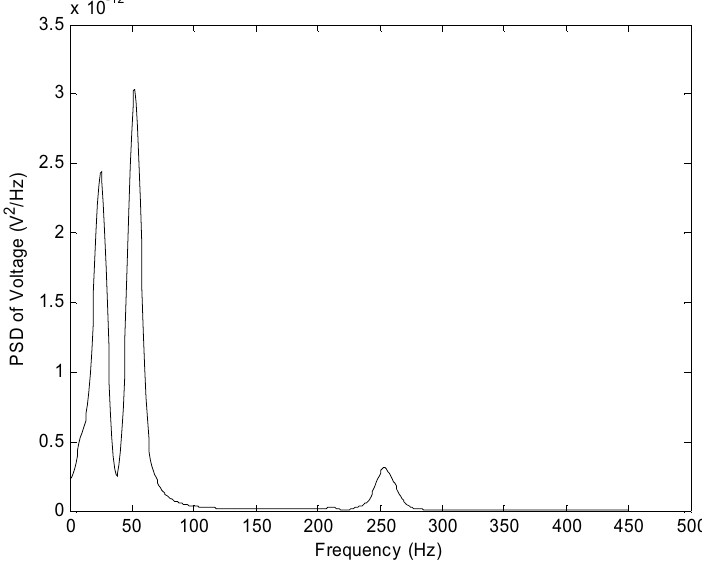
Fig. 12. Frequency spectrum of the PZT sensor voltage of Fig. 11.